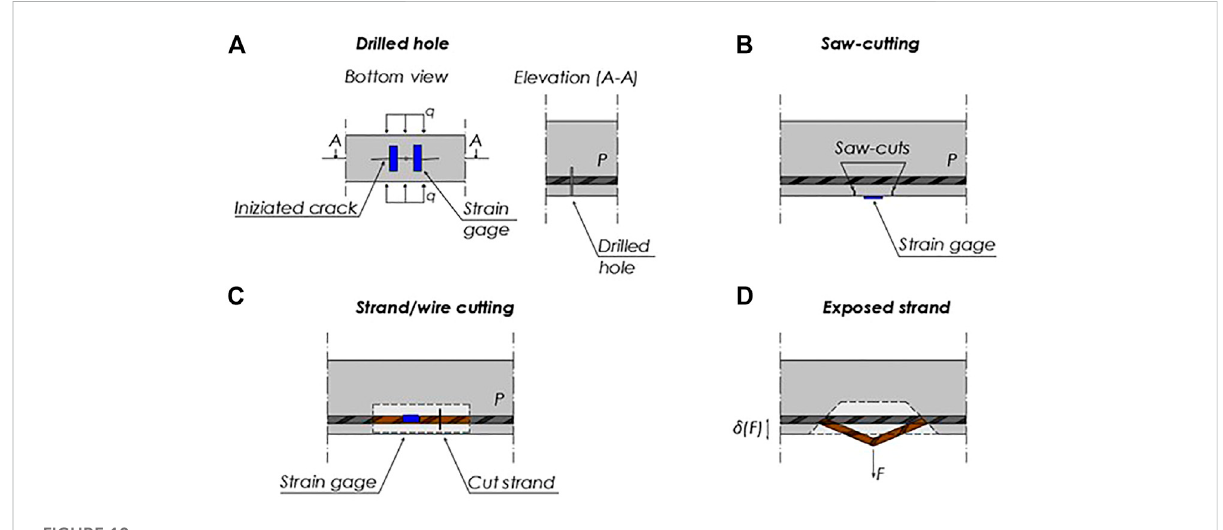
FIGURE 10 Indirect methods for prestress loss